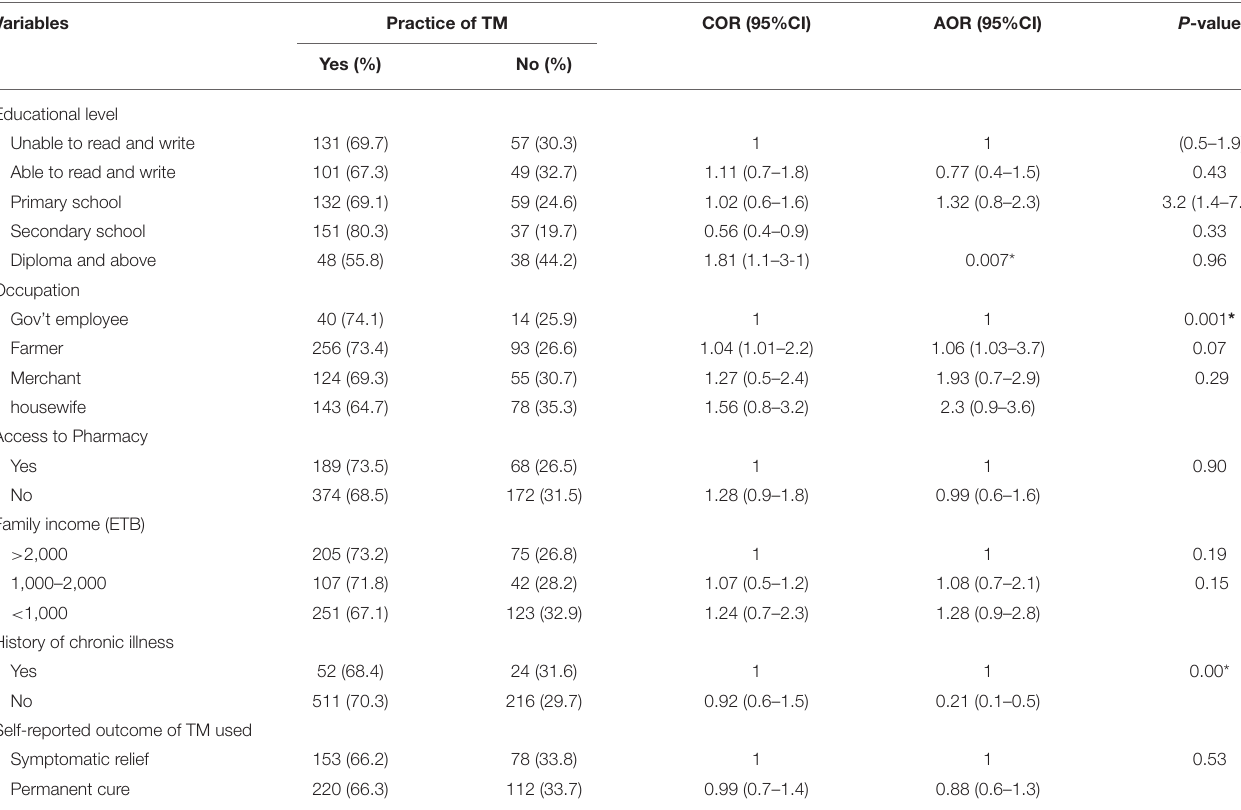
TABLE 4 | Multivariable analysis of factors associated with traditional medicine